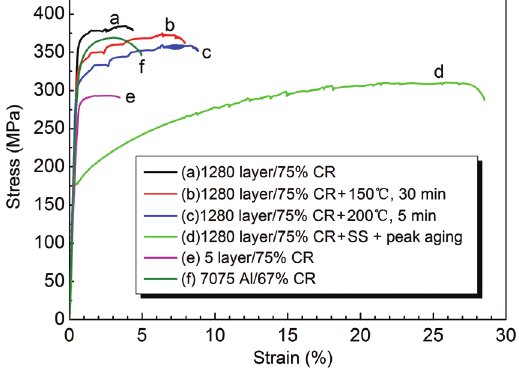
Figure 7 Tensile engineering stress-strain curves of the processed composite